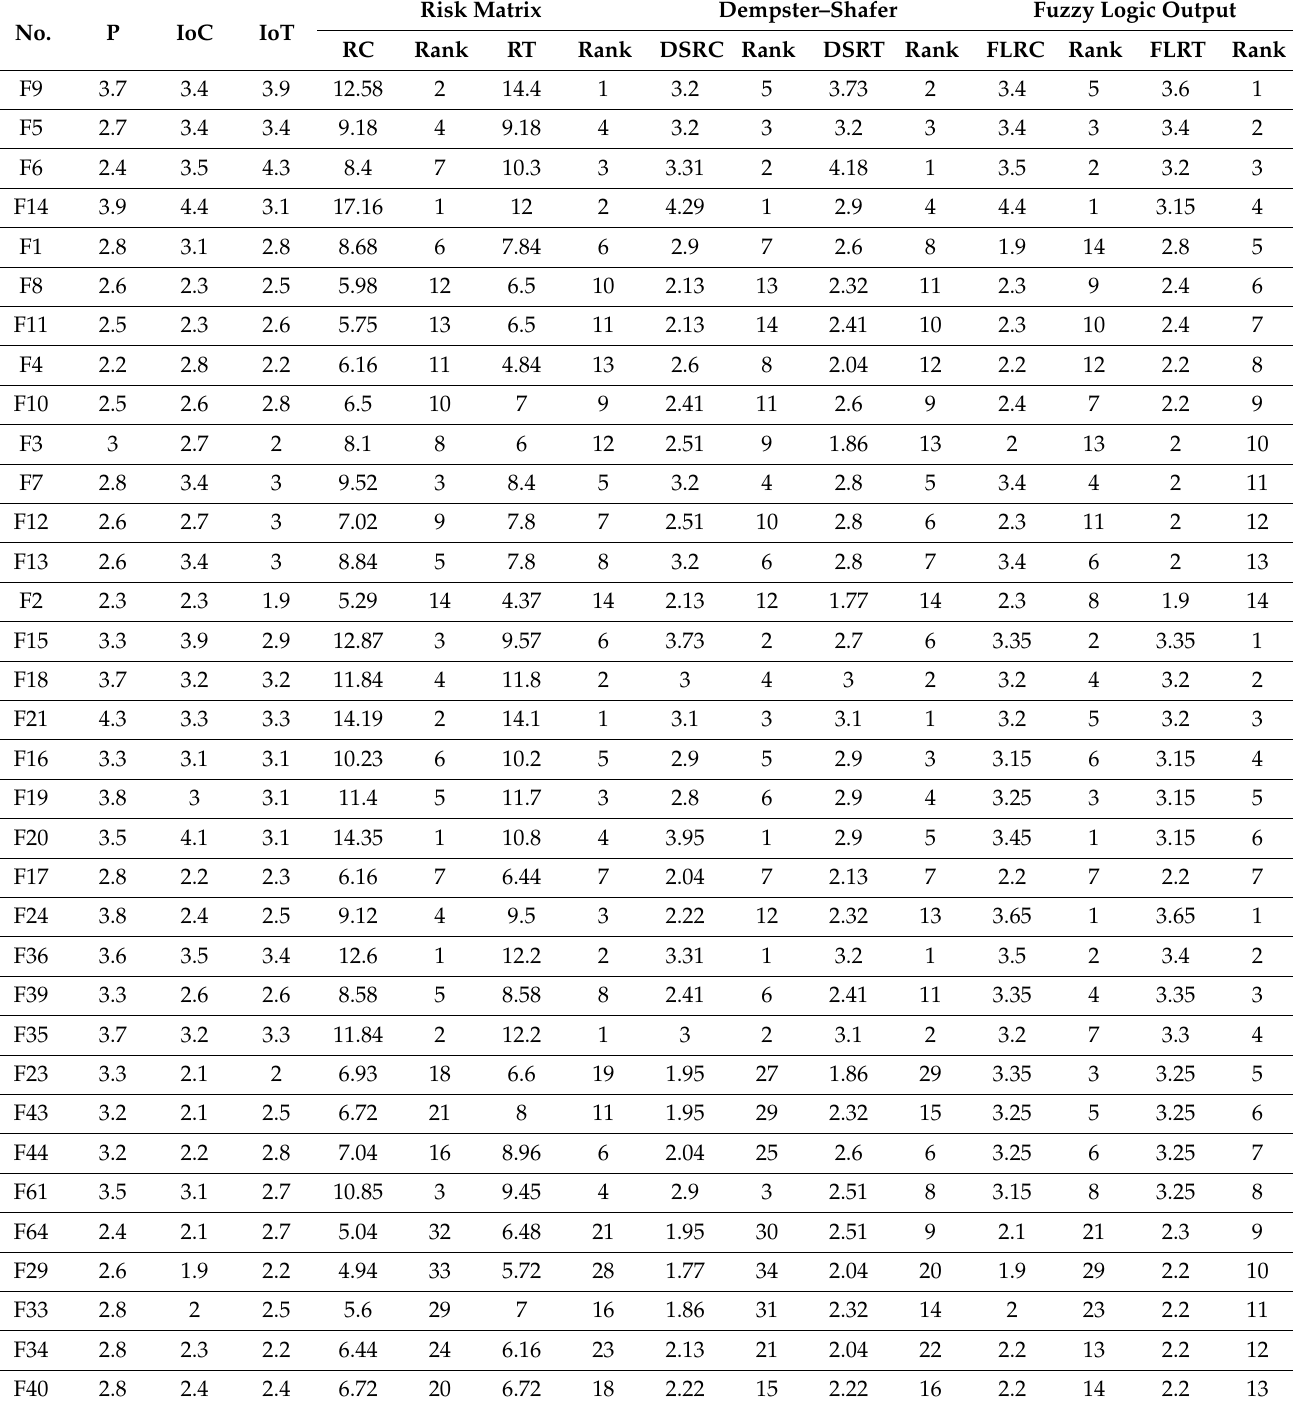
Table 6. Comparative analysis of the obtained